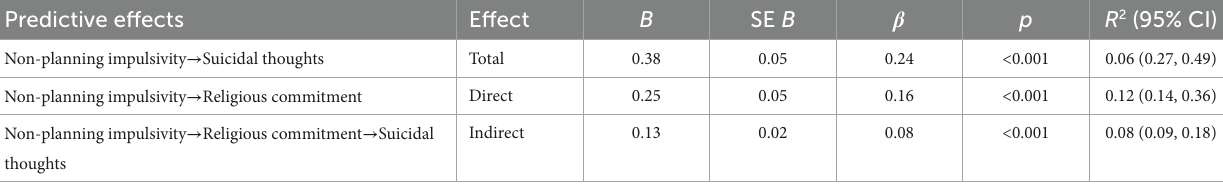
TABLE 4 Relationship between impulsivity and suicidal